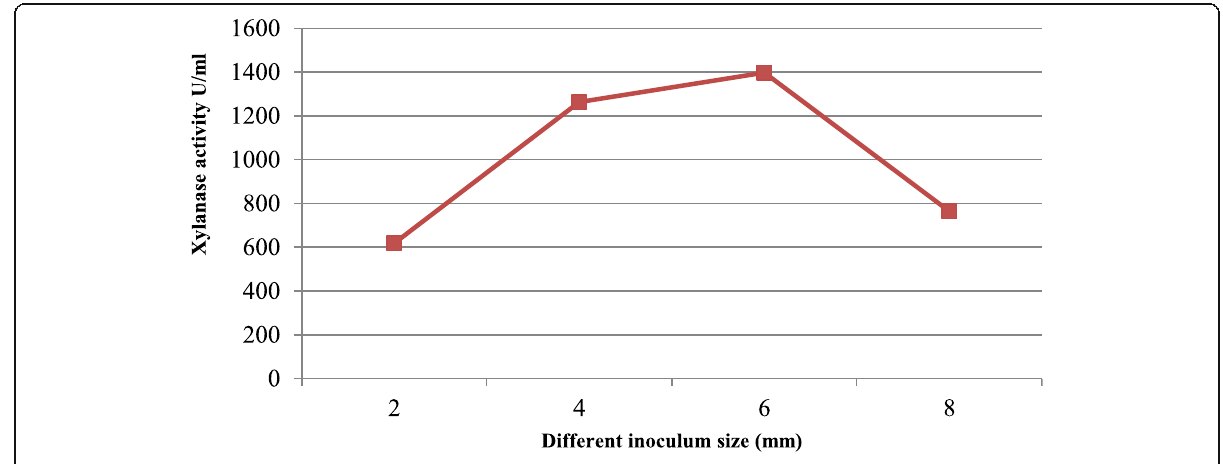
Fig. 3 Effect of different inoculum size on xylanase production